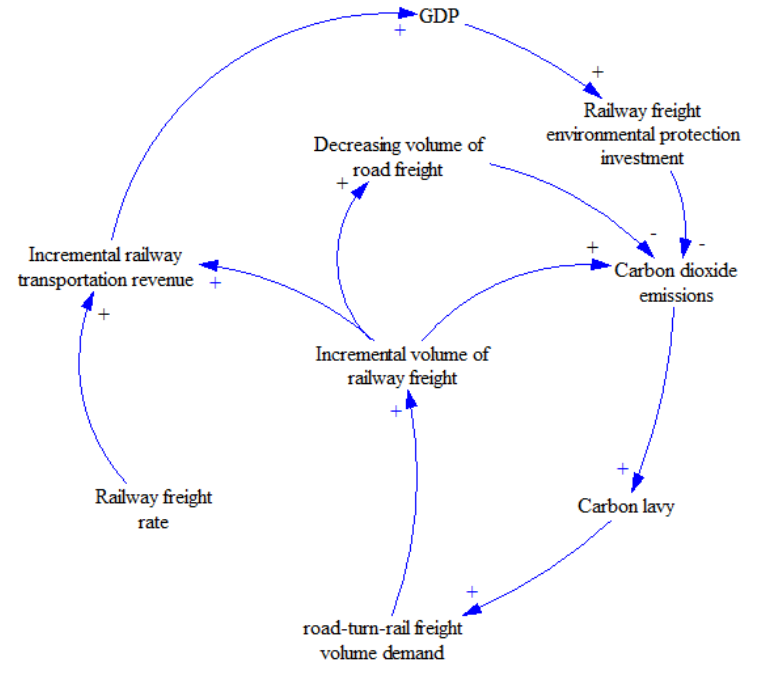
Figure 2. Causality diagram.